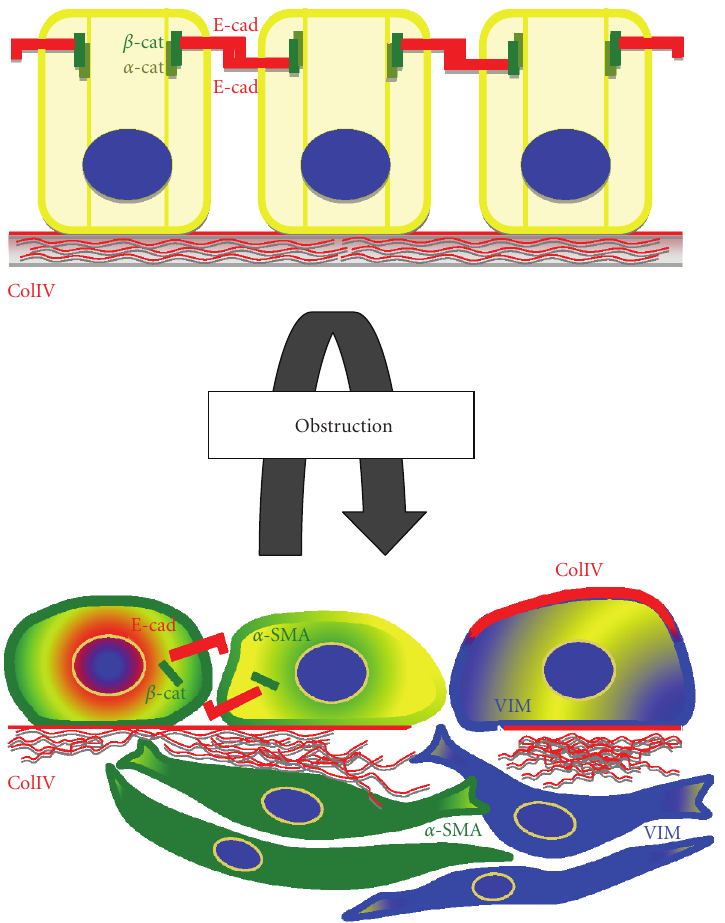
Figure 8: Paradigm of changes associated with human congenital urinary tract obstruction . The obstruction of the developing kidneys causes dissociation of the cytoskeletal proteins (E-cadherin, β -catenin) and their translocation to the cytoplasm and the nucleus. A ff ected cells become flattened and start expressing mesenchymal markers (vimentin, α -SMA) giving them more flexibility and contractility. Breakdown of the ductal basement membrane allows the cells to migrate into the interstitium and to contribute to the myoepthelial population of periductal